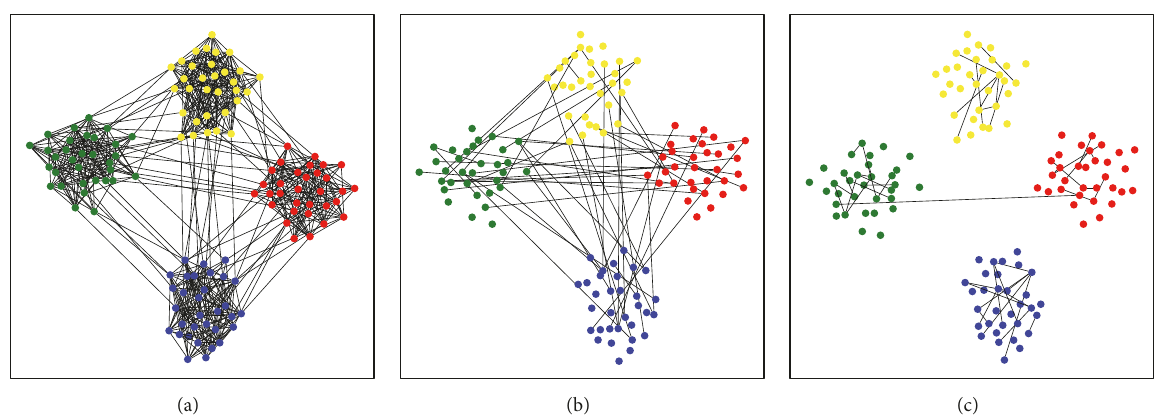
Figure 9: Results for improving efficiency of transforming a benchmark network to a small-world network. The figures show the topology of 𝑘 = 50 added edges on a benchmark network. (a) shows the topology of the initial network. (b)-(c) hide the initial edges and show the added edges. (b) shows the topology of 𝑘 = 50 added edges via the NW model. (c) shows the topology of added edges 𝑘 = 50 via the GSA